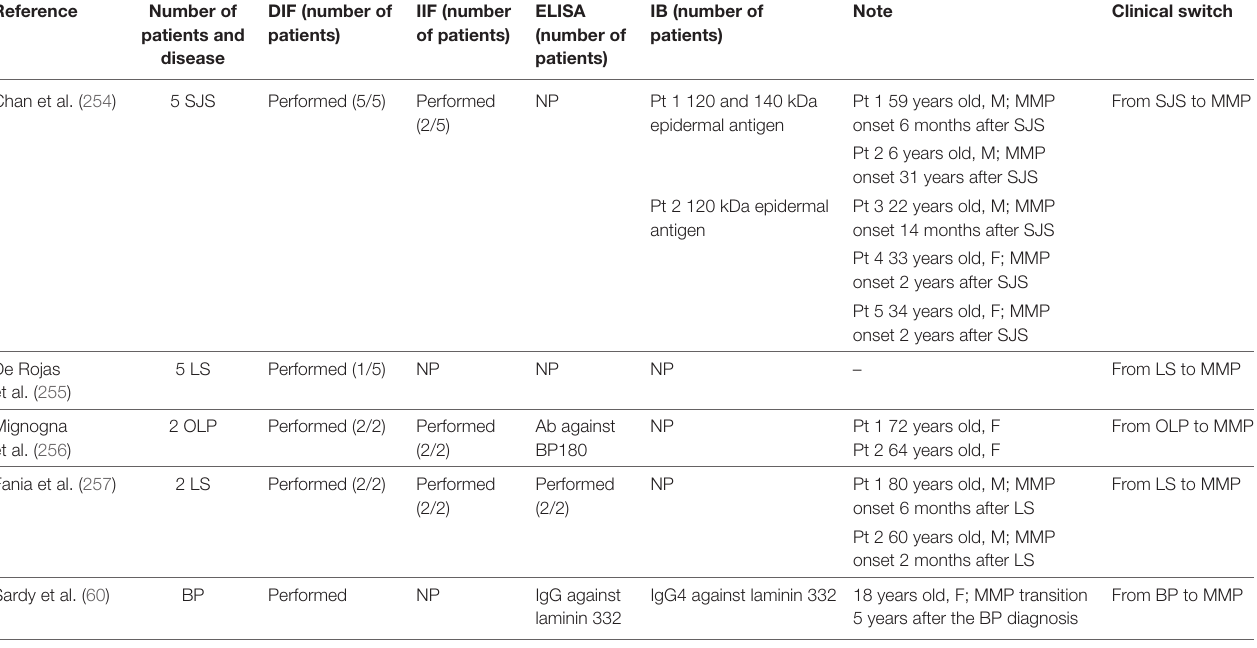
TABLe 8 | Reported case of switch to